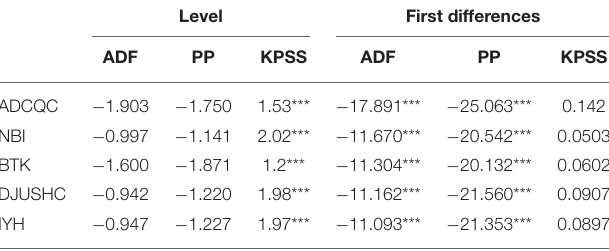
TABLE 5 | Unit root test